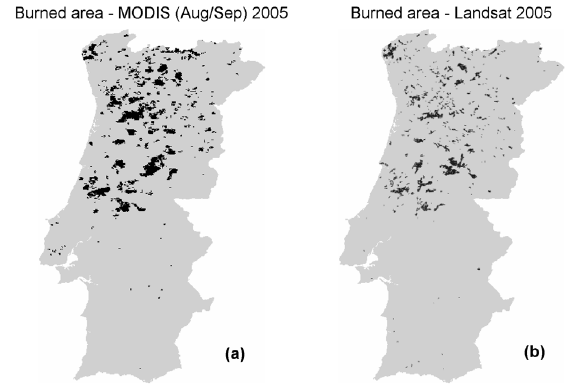
Figure 5 - Burned area map for August and September 2005, as obtained by the algorithm based on MODIS imagery (a) and the reference map for the whole year of 2005, based on Landsat imagery (b) .